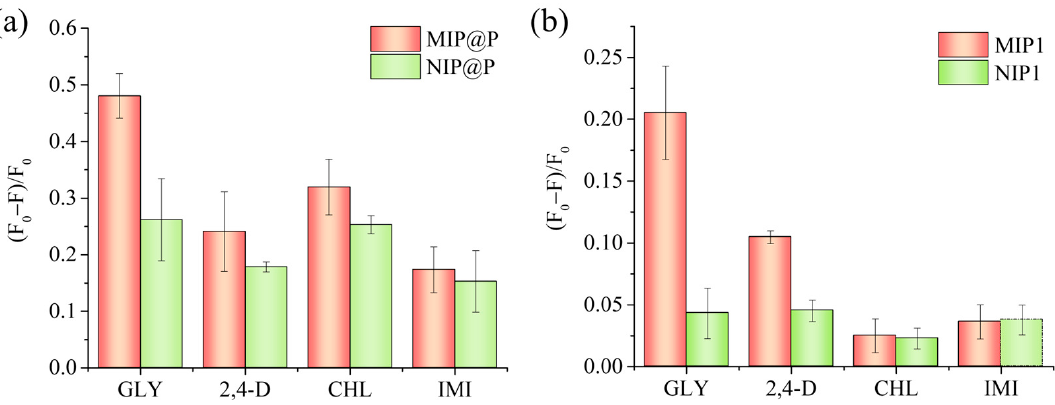
Figure 5. Fluorescence response of MIP@P and NIP@P ( a ), and MIP1 and NIP1 ( b ) to the testing pesticides. GLY, glyphosate; 2,4 ‐ D, 2,4 ‐ dichloro ‐ phenoxyacetic acid; CHL, chlorpyrifos; IMI, im ‐